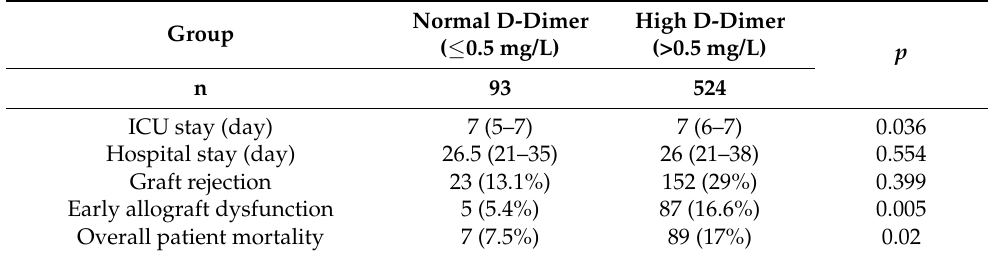
Table 5. Comparison of postoperative outcomes between the normal and high D-dimer groups.